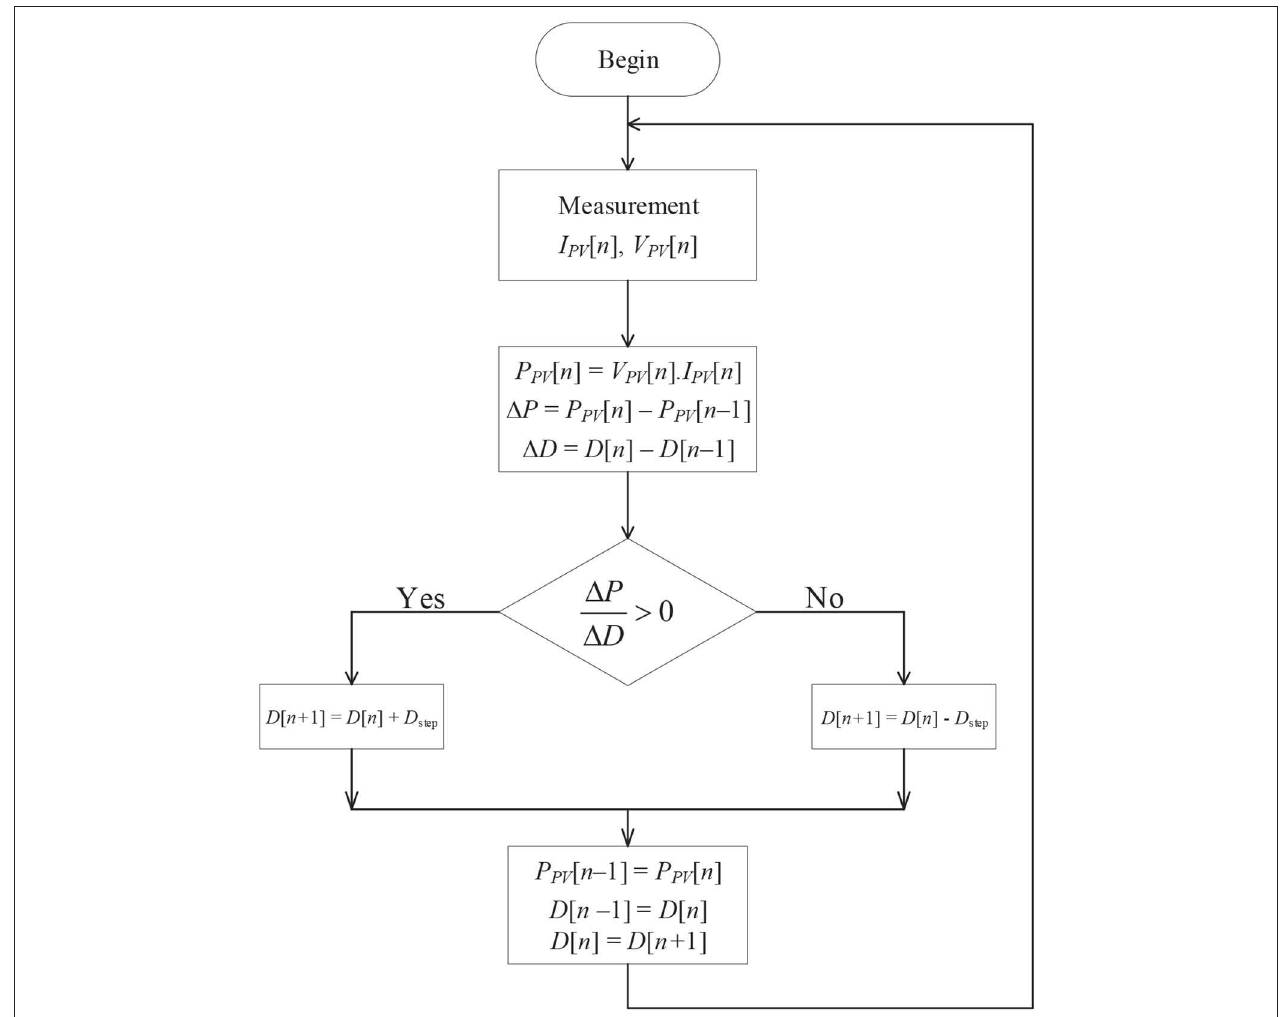
FIGURE 6 | The flowchart for the proposed MPPT